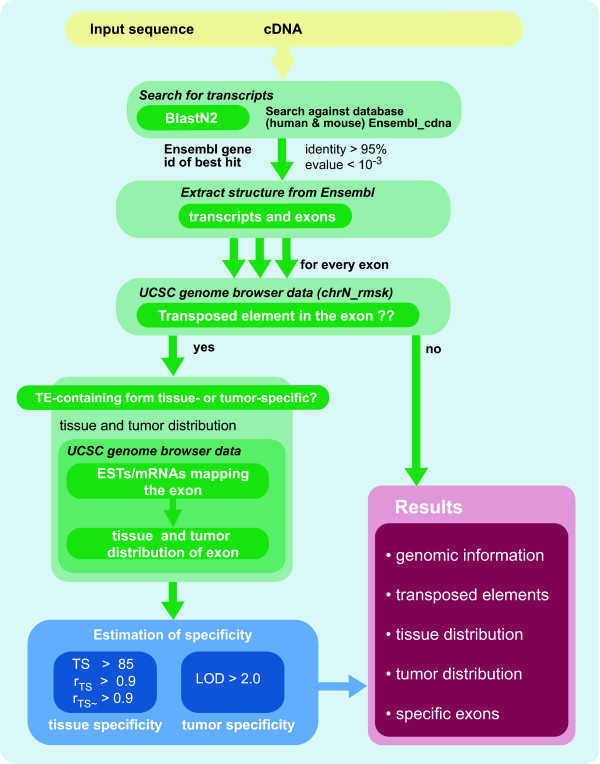
Work flow of SERpredict. Programs and rules used for extracting tissue- or tumor-specific TE-containing exons, for details see Section "Work flow in SERpredict".